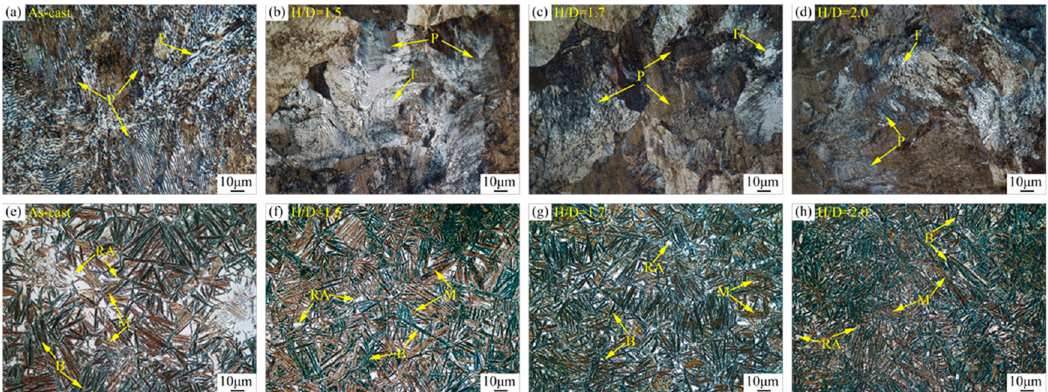
Figure 4. Optical microstructure (OM) of 0.4C-Si-Mn-Cr steel before and after heat treatment with different H/D values for the deformation process. ( a – d ) Before heat treatment and ( e – h ) after heat treatment. P: pearlite, F: ferrite, B: bainite, M: martensite, and RA: retained austenite.